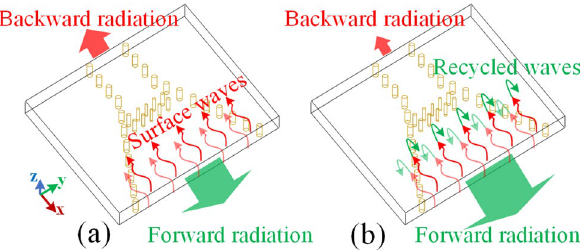
Figure 9. The proposed mechanism for tailoring the radiation characteristics ( a ) the phase corrected SIW H-plane horn, ( b ) the field manipulation method.